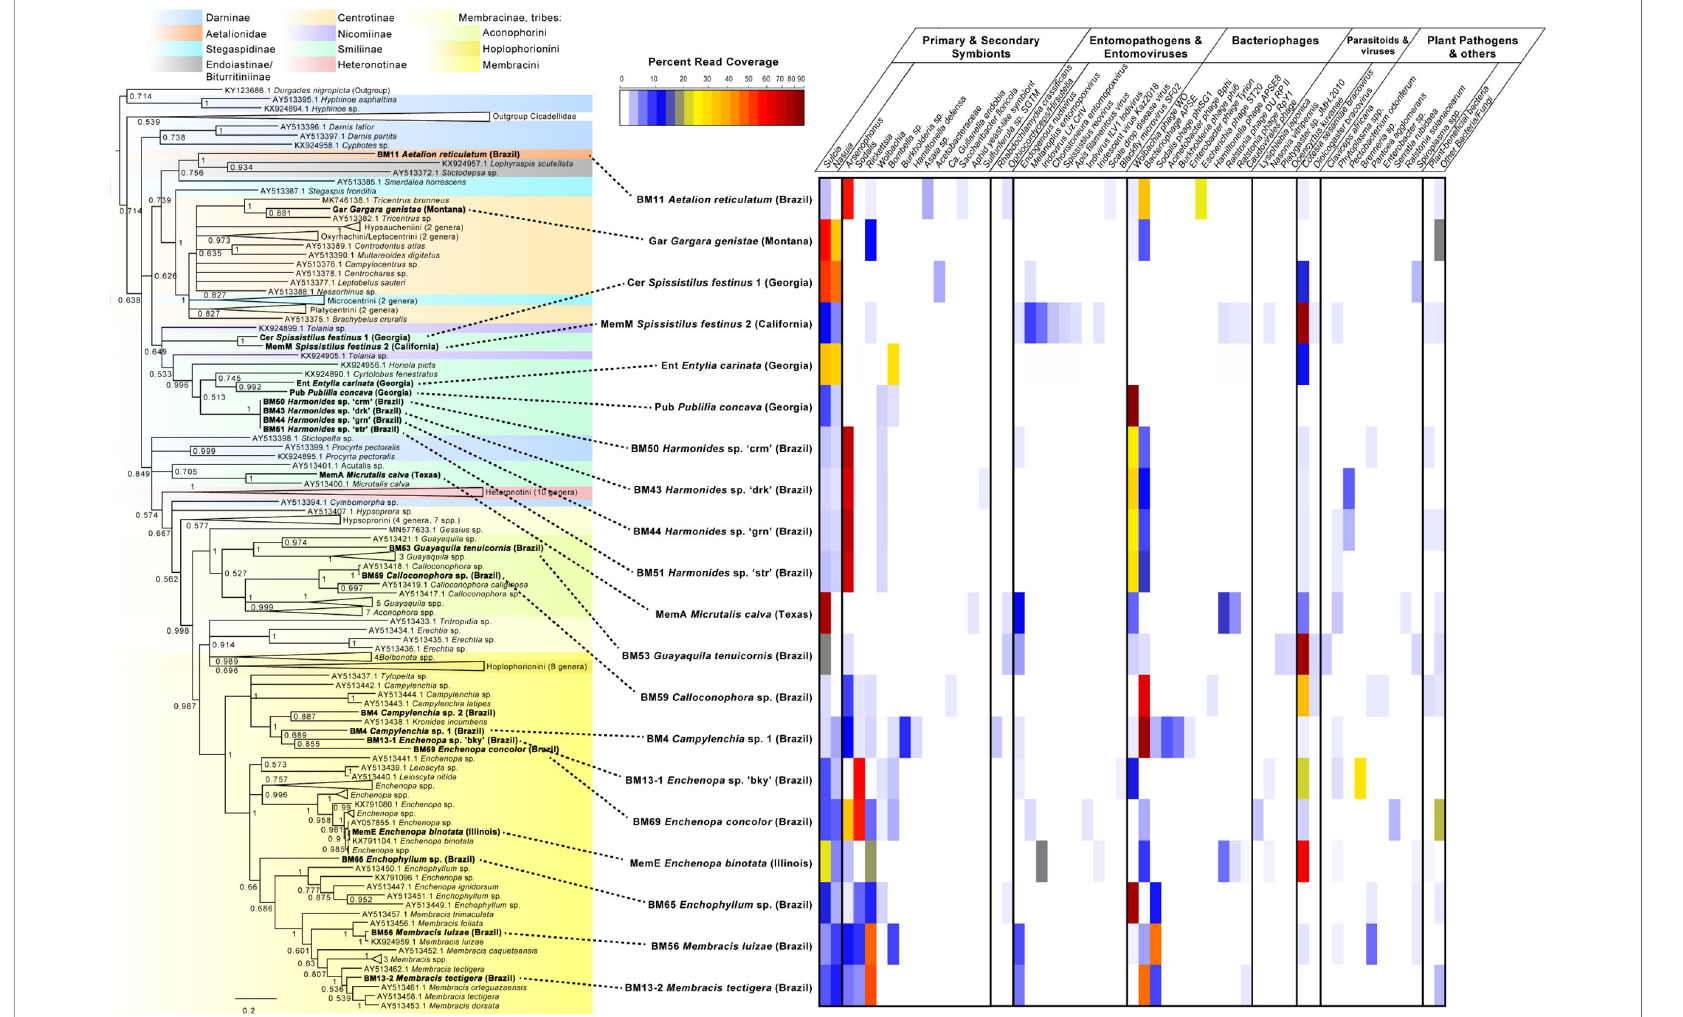
FIGURE 2 | Phylogenetic tree and abundance plot of symbionts and plant pathogens of membracids in this study. Phylogeny is based on 956 aligned positions of the partial cytochrome oxidase I (COI) gene, generated using Bayesian 50% majority rule in MrBayes with GTR+G with 4 rate categories model, and showing posterior probabilities on branches (a similar topology with similar support was generated by RAxML GTR+Gamma with 100 bootstrap replicates). Specimens included in this study are shown in bold font. The presence and abundance plot is based on blastn hits to assembly scaffolds of symbionts, microbes, and pathogens, is depicted in the abundance heatmap as read coverage normalized as a percentage of the read coverage per scaffolds with blast hits from each sample, shown in color legend. Categories in abundance plot were classi fi ed based on predominant function of closest blast hit, and include putative primary and secondary membracid symbionts (bacterial and fungal); putative entomopathogens (including bacteria and fungi) and entomoviruses; bacteriophages, parasitoid wasps, and their viruses; potential fungal and bacterial plant pathogens; other bacteria and